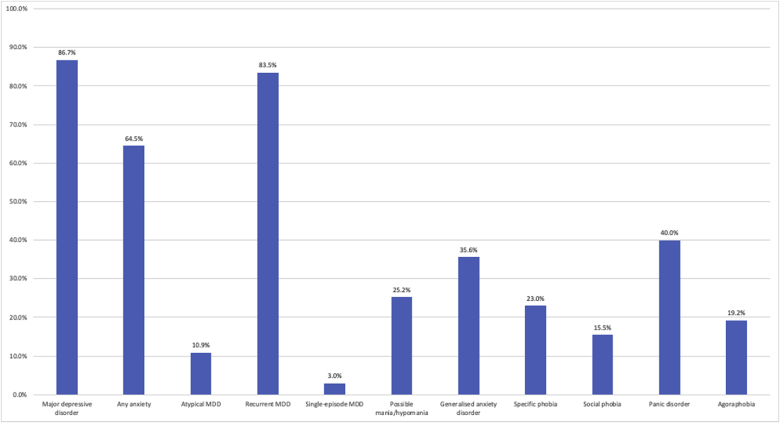
Lifetime prevalence of probable psychiatric disorders in the GLAD sample.Percentages refer to the proportion of participants who meet cut-off criteria on lifetime measures for the specified disorder as defined by the DSM-5 (American Psychiatric Association, 2013) out of the total. Possible mania was assessed by the Mood Disorder Questionnaire (MDQ) (Hirschfeld, 2002).